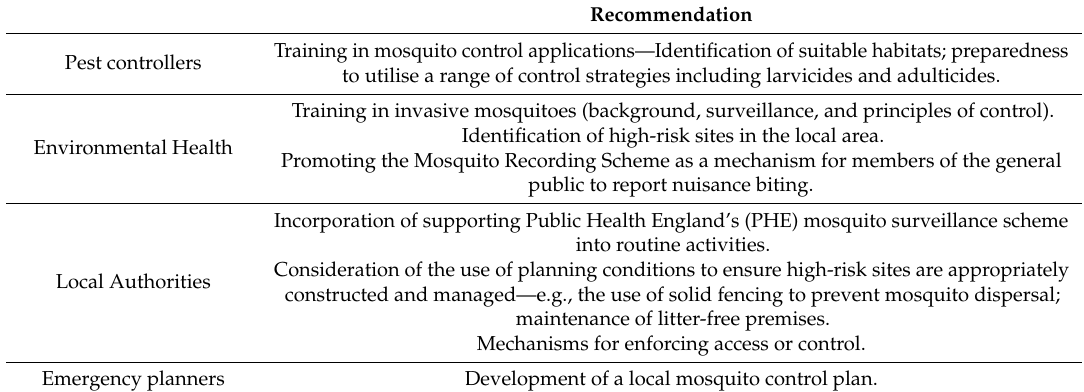
Table 3. Recommendations listed for pest controllers, environmental health, local authorities, and emergency